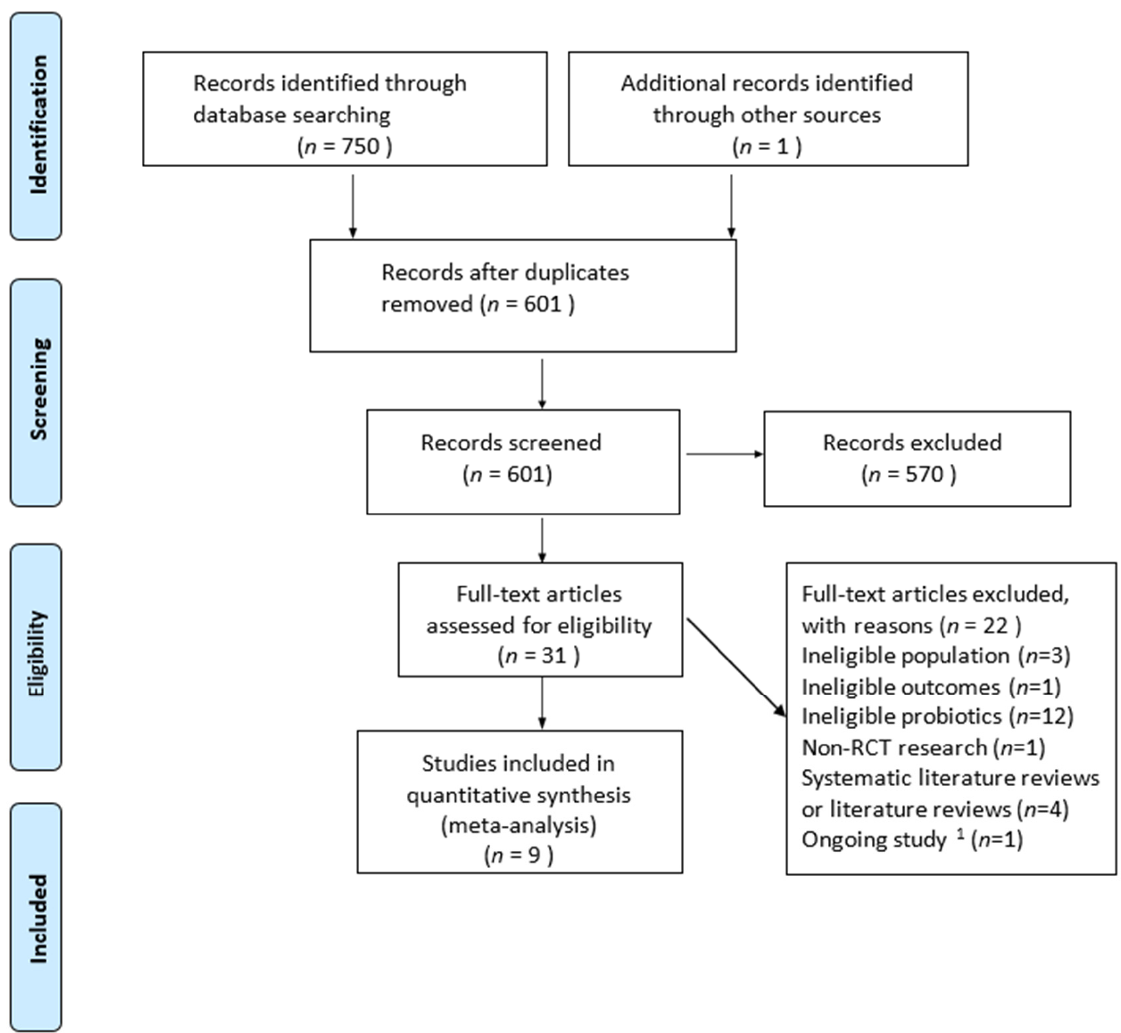
Figure 1. Preferred Reporting Items for Systematic Reviews and Meta-Analyses (PRISMA) flow diagram. 1 Ongoing study: the research is still in progress.